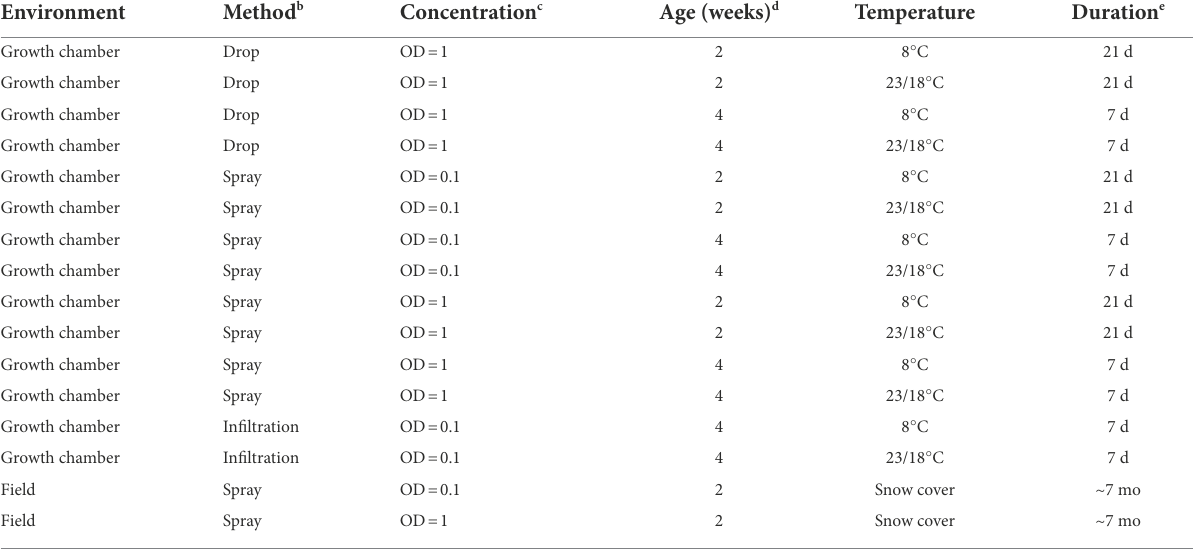
TABLE 1 Methods used to test infection of Arabidopsis with P. arabidopsidicola strain C29 a .